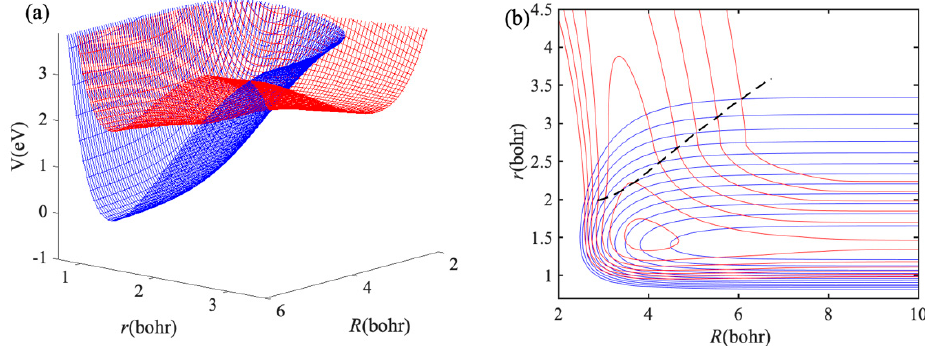
Figure 3. ( a ) A 3D plot of two lowest diabatic PESs for NaH 2 at C 2 v geometry. ( b ) Contour plot of (a), and the dash line represents the crossing of two diabatic